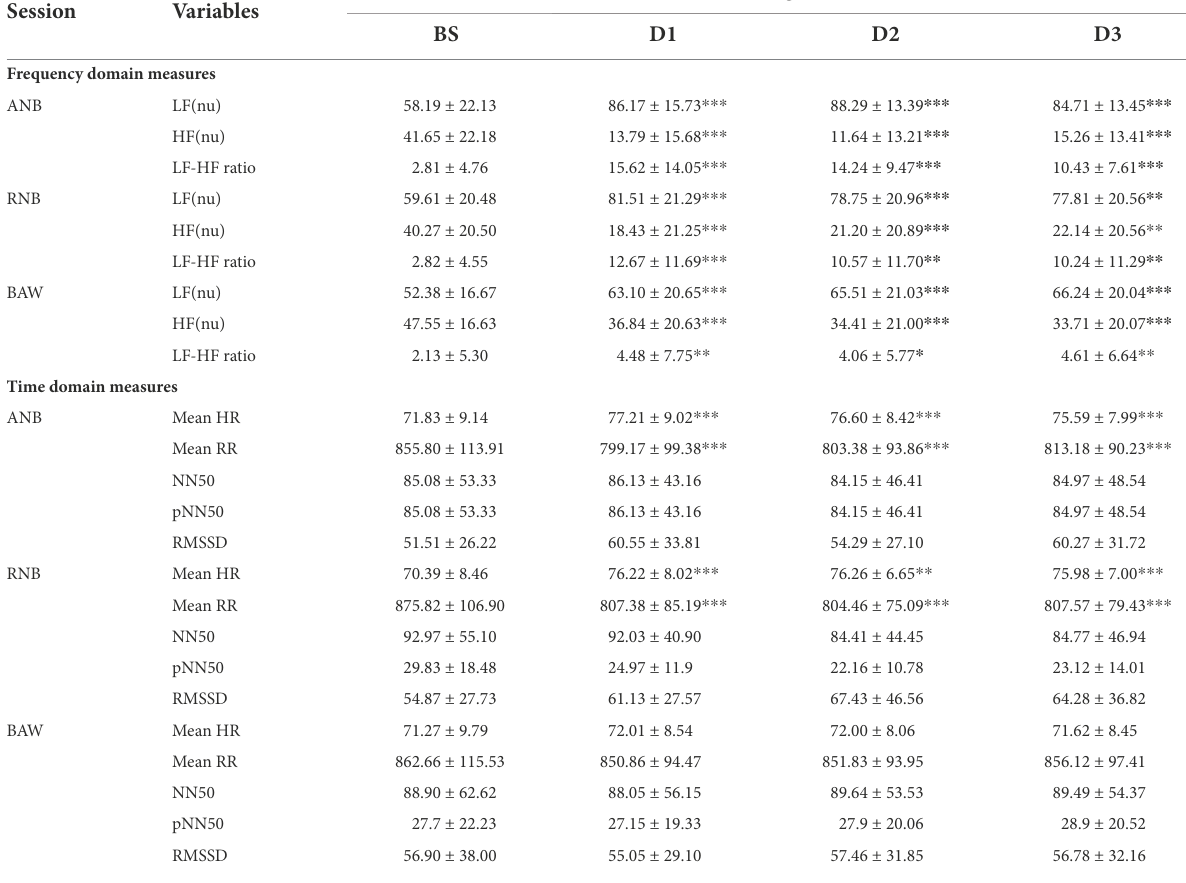
TABLE 3 HRV measures at baseline and during yoga breathing practices. Values are group mean ± SD ( n =